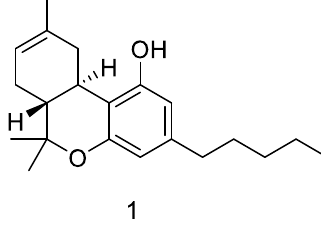
Figure 6. Δ 8 -THC chemical